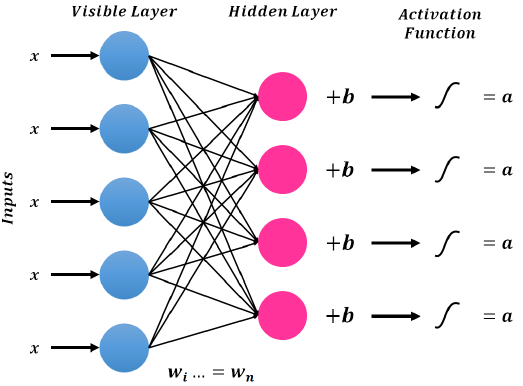
Figure 5. A general architecture of the Restricted Boltzmann Machines